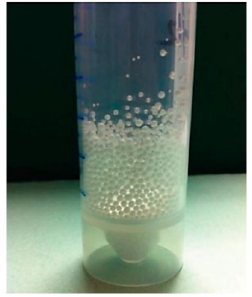
Figure 6. Optical image of the MCs produced [54].